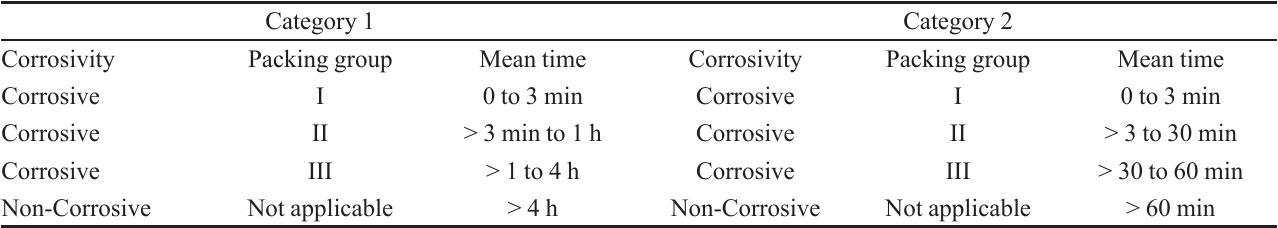
TABLE I - UN Packing Group assignment Table. Group I: great danger; Group II: medium danger; Group III: least danger (DOT)